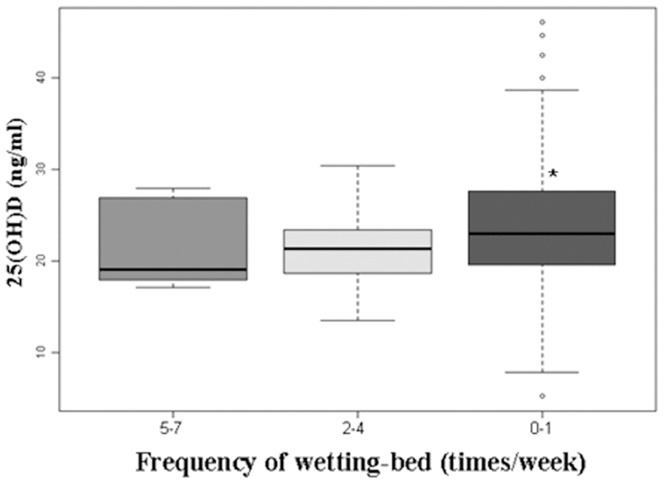
The effect of 25(OH)D on the frequency of bedwetting.Serum 25(OH)D concentrations (mean ± SD): 5–7 times/week: 18.3±4.8(ng/ml); 2–4 times/week: 20.9±4.1(ng/ml); 0–1 times/week: 23.6±6.4 (ng/ml). Compared to the 5–7 times/week and 2–4 times/week groups, the concentrations of 25(OH)D in the 0–1 times/week group were much higher (P<0.05). 25(OH)D, 25-hydroxyvitamin D.